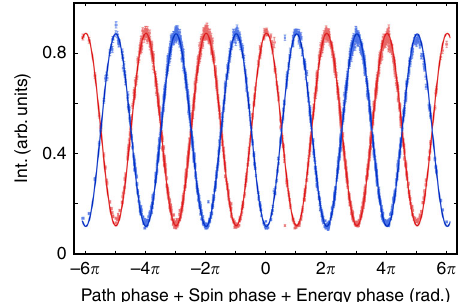
Fig. 3 The complete dataset and fi tting curve for the triply entangled state. The spin, path, and energy phases are summed and plotted vs. the normalized intensity. The red (blue) data points correspond to neutrons in the up (down) state before the fi rst π /2 fl ipper. The fi t contrast for the red curve is 0.768 and for the blue curve is